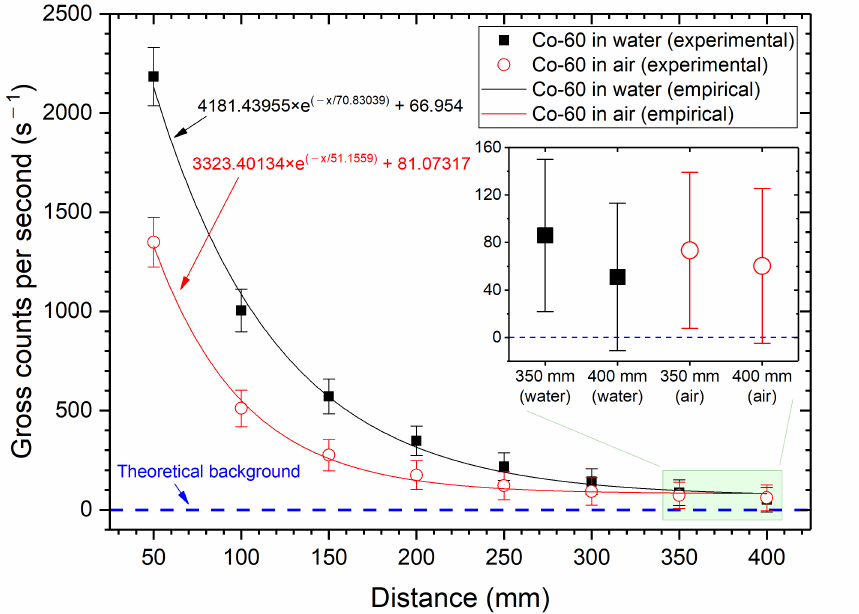
Figure 8. Gross counts per second of Co-60 as a function of the